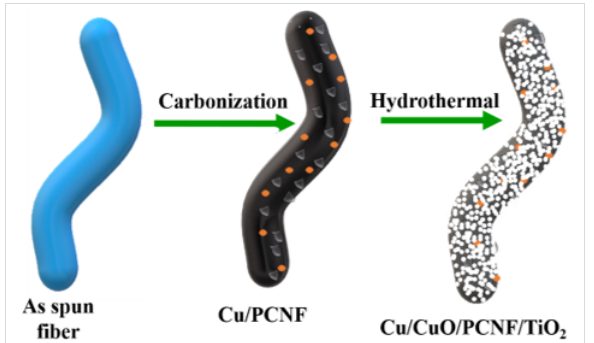
Figure 1: Schematic illustration shows the morphological changes during different synthesis